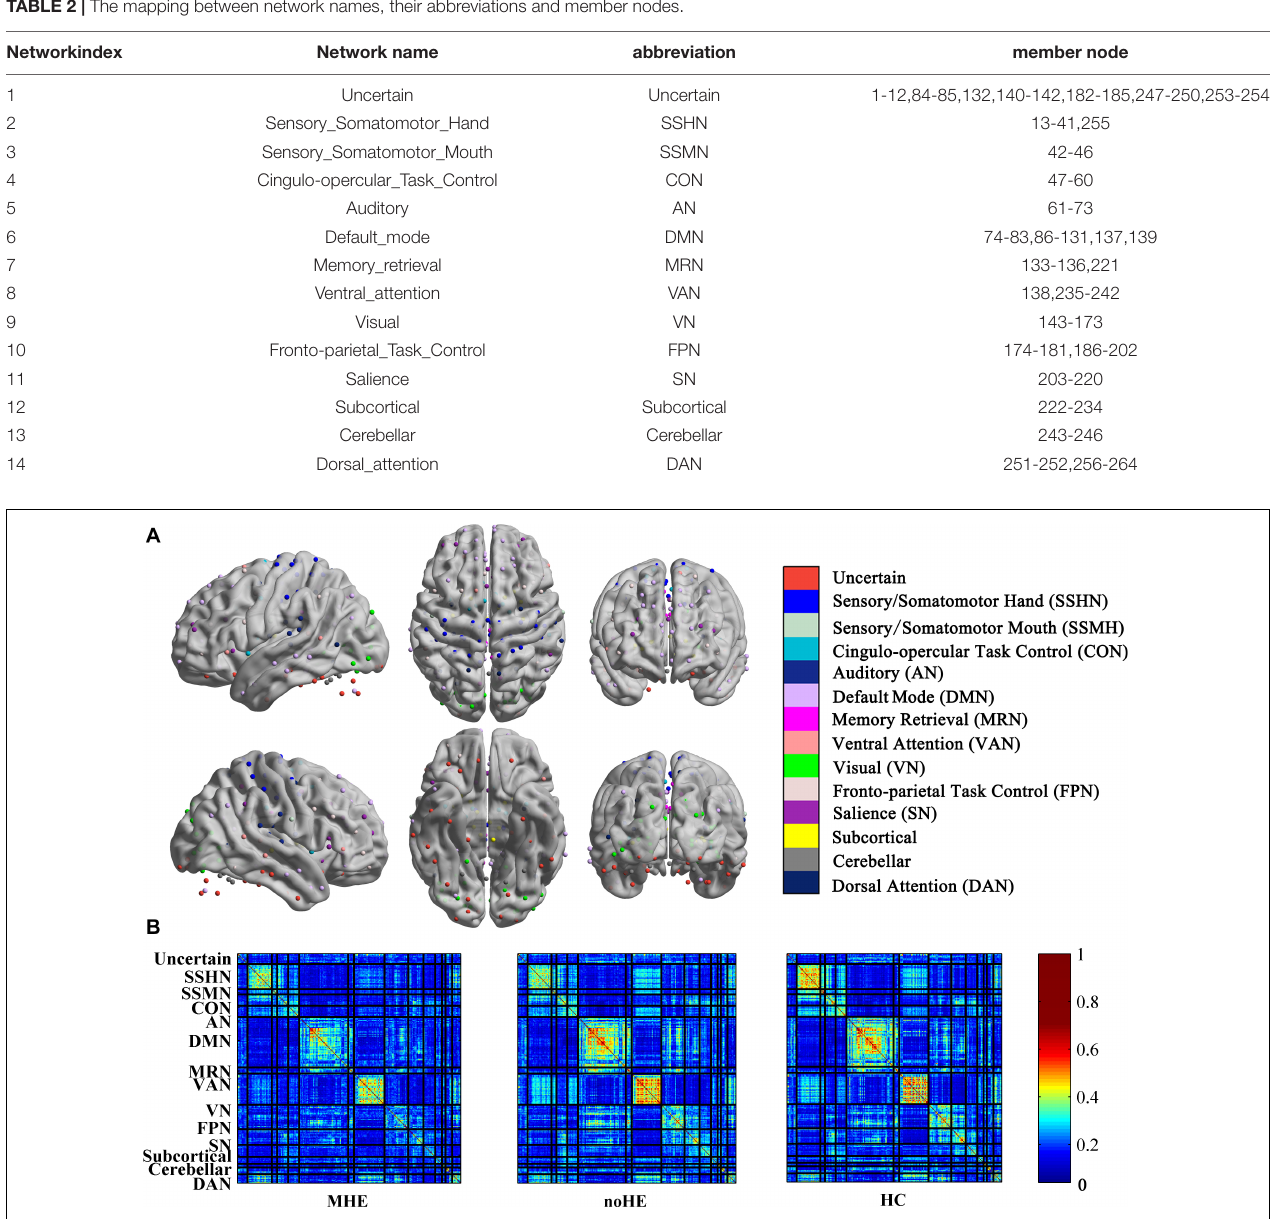
FIGURE 2 | The connection stability profile of the brain network across time in MHE, noHE and HC groups. (A) The distribution of 14 brain networks in the 264-node brain template; (B) The connection-stability matrix distributed in the 14 networks in MHE, noHE and HC groups. MHE, minimal hepatic encephalopathy; noHE, non-hepatic encephalopathy; HC, health